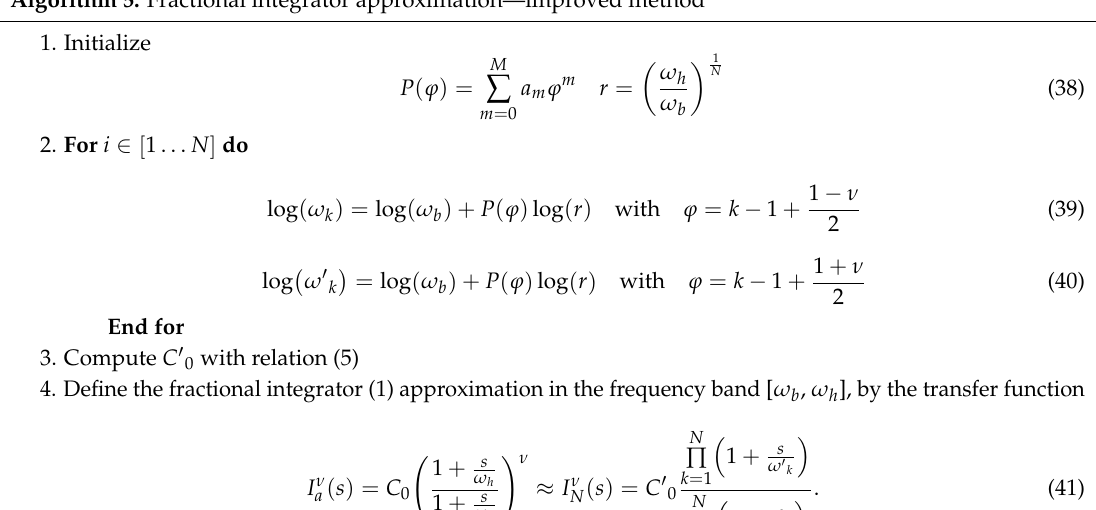
Algorithm 5. Fractional integrator approximation—improved method